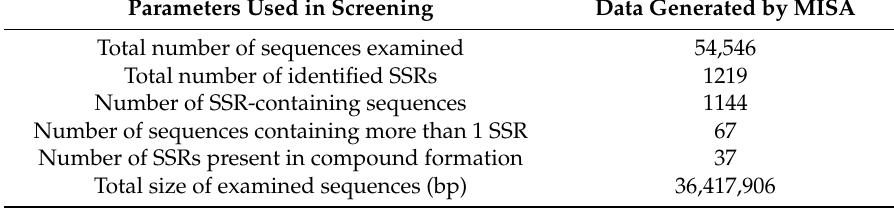
Table 1. Summary of the in silico search for simple sequence repeats (SSRs) in Pogostemon cablin .